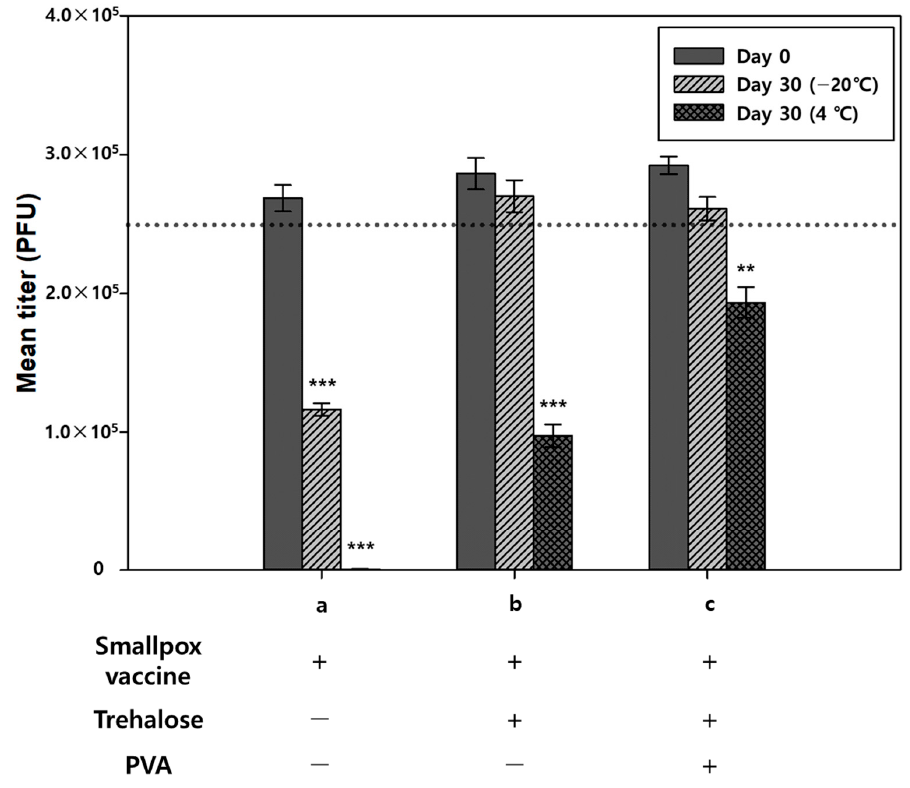
Figure 4. One-month storage stability of vaccine-coated microneedles stored at 4 ◦ C and − 20 ◦ C. ( a ) Smallpox vaccine only (F1), ( b ) smallpox vaccine + trehalose (F3), and ( c ) smallpox vaccine + polyvinyl alcohol (PVA) + trehalose (F4). Dotted line indicates the targeted virus coating amount. Statistical significance compared to the Day 0 sample was determined by a t -test (** p < 0.01, *** p < 0.001).